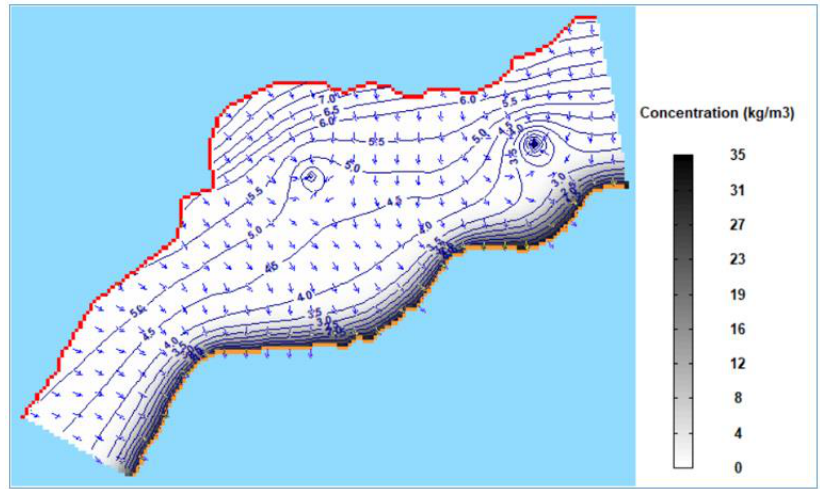
Figure A9. Groundwater piezometry in 2100 and concentration at the surface in layer 1 under the RCP 4.5 scenario.